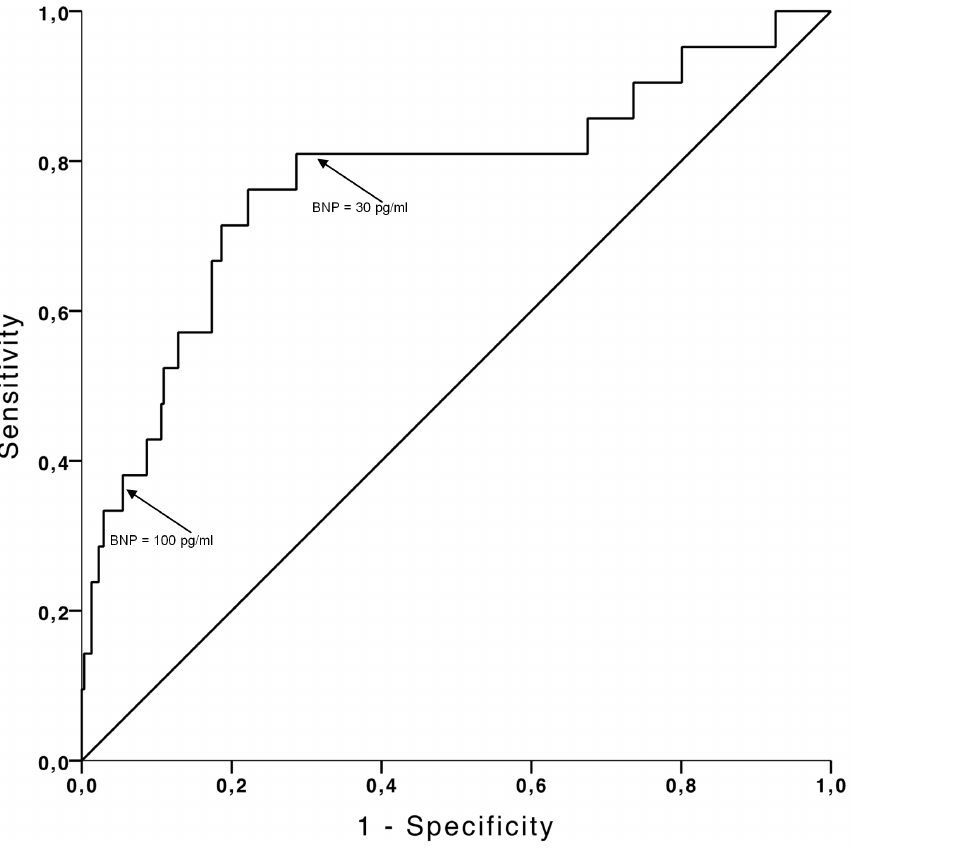
Figure 1. Received operating characteristic (ROC) curve for detection of CHF by BNP in patients treated with cardiotoxic chemotherapy. Area under the curve is 0.77 (95% CI 0.65–0.90, p , 0.001). The arrows indicate selected cut-off concentrations of BNP. BNP concentration of 100 pg/ml correspond to a sensitivity 38% of and a specificity of 92% and BNP concentration of 30 pg/ml corresponds to a sensitivity 81% of and a specificity of 62%.